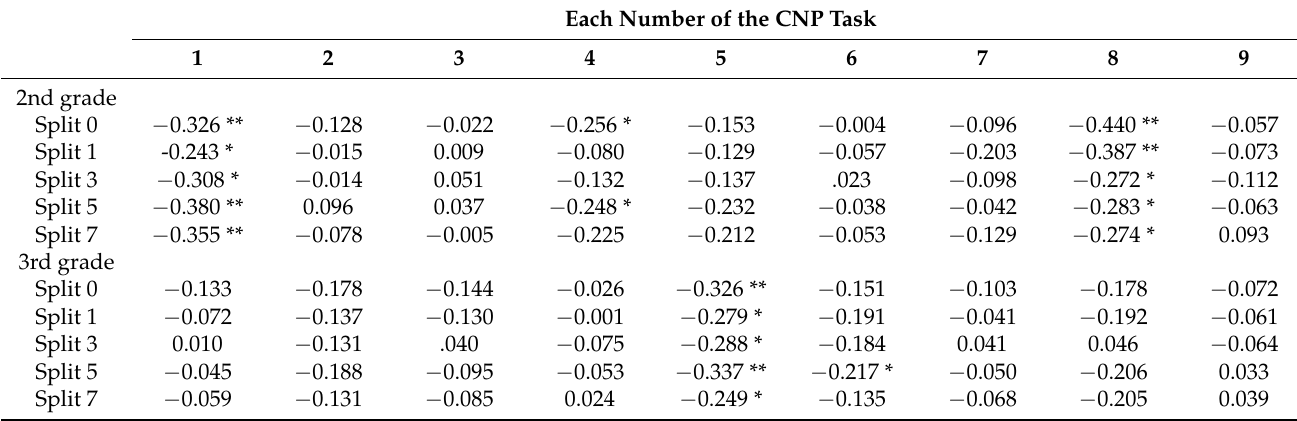
Table 4. Correlation between CNP task accuracy and AF task RT in Experiment